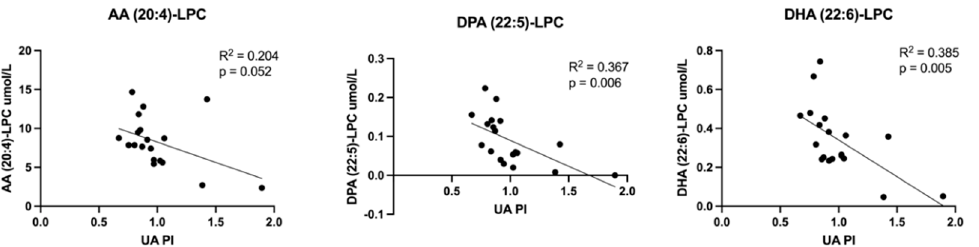
Figure 8. Correlations between umbilical vein plasma lipid concentrations and umbilical artery pulsatility index (UA PI): lysophosphatidylcholines. Scatterplots demonstrate correlation relationships between UA PI and umbilical vein plasma concentrations of lysophosphatidylcholine (LPC) molecules containing long chain polyunsaturated fatty acids. Abbreviations: AA, arachidonic acid; DPA, docosapentaenoic acid; DHA, docosahexaenoic acid. Pearson correlation coefficient was computed to assess relationships.